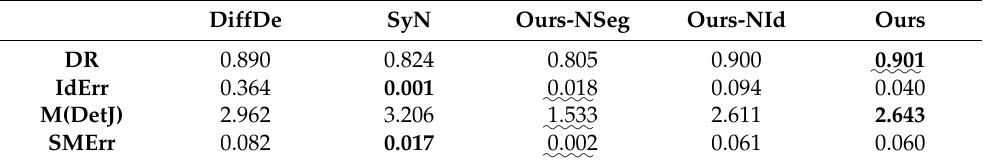
Table 1. The quantitative results of Section 3.2 with smoothing parameters Kf 1 Kd 1 are shown. The first row lists the methods, and the second to the fifth rows represent the Dice ratio ( DR ), the identity error ( IdErr ), the maximum Jacobian determinant of the transformations ( M(DetJ) ), and the smoothness error ( SMErr ), respectively. The numbers with wavy lines are the best among Ours-NSeg , Ours-NId , and Ours . The bolded numbers are the best among DiffDe , SyN , and Ours . DiffDe SyN Ours-NSeg Ours-NId Ours DR 0.890 0.824